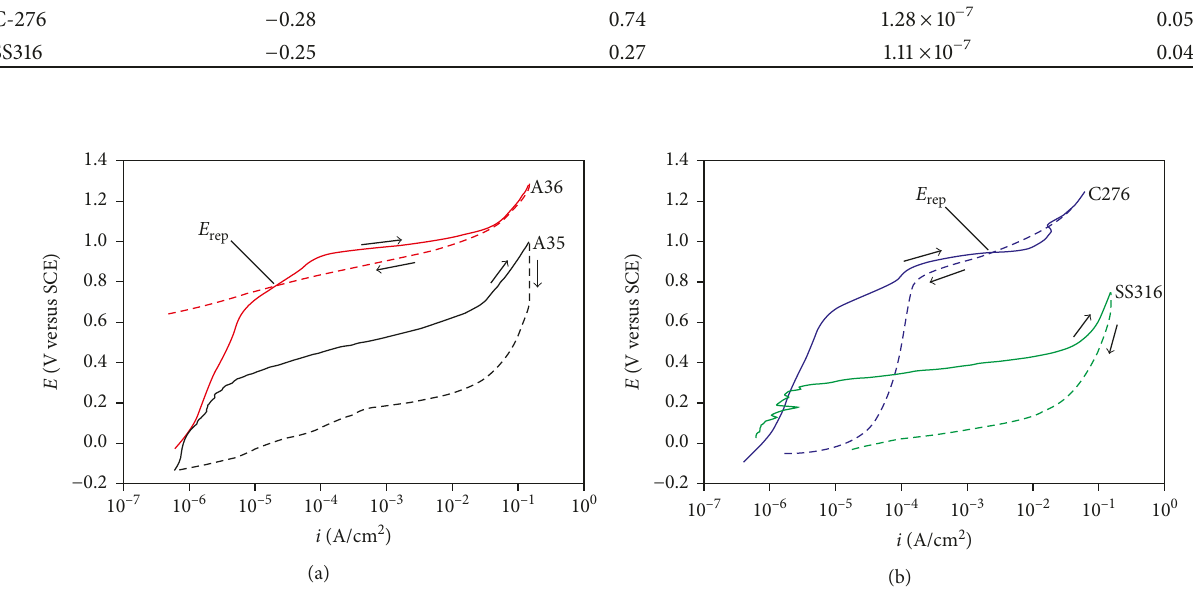
Figure 7: Cyclic anodic polarization curves of A35, A36, C-276, and SS316 alloys in 3.5wt.% NaCl solution at 25 ° C.